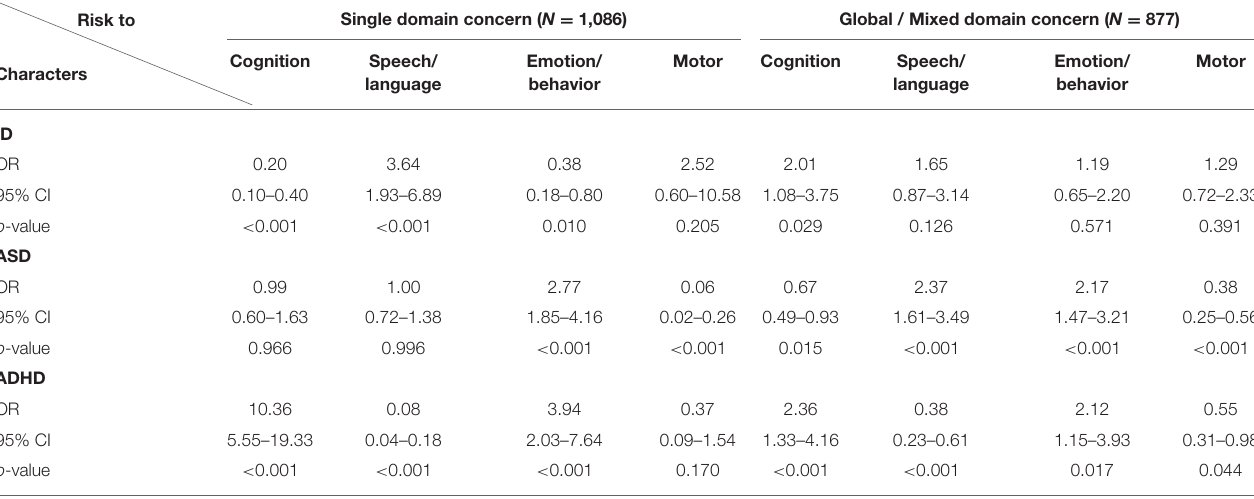
TABLE 4 | Simple logistic regression of caregivers’ concerns about developmental domains in children with and without ID, ASD, or ADHD. CharactersRisk